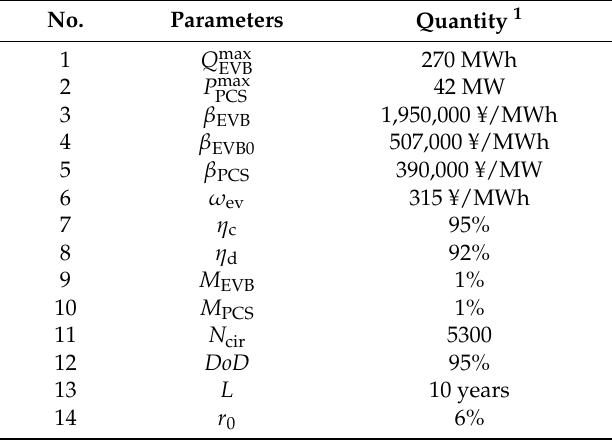
Figure 7. Pool purchase price of wind power. Table 1. Parameters of the centralized charging station.